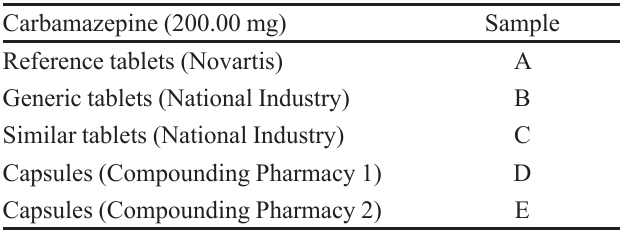
magistral capsules of carbamazepine 200.00